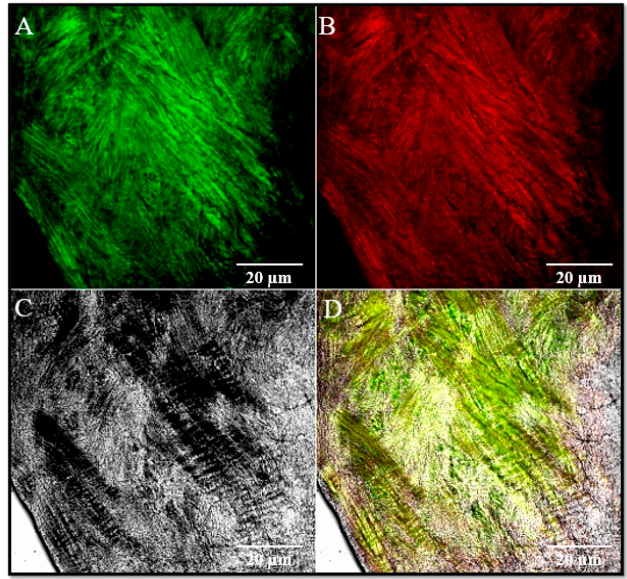
Figure 2. Double localization immunofluorescence reaction performed on discal lateral ligament using antibody against Collagen I ( A ), green channel and Elastin ( B ), red channel. Pictures show an intense fluorescence pattern for both proteins ( A , B ). ( C ), transmitted light (TL); ( D ), the yellow fluorescence depends on the merge of green and red channels. Magnification: 40x.